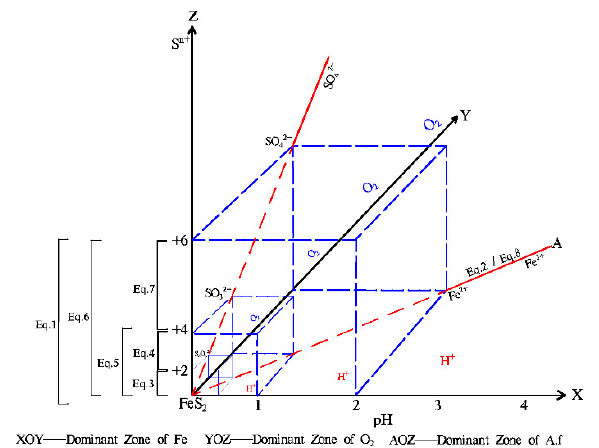
Figure 3. FeS 2 +H 2 O+O 2 reaction diagram in abandoned coal mines of Shanxi.